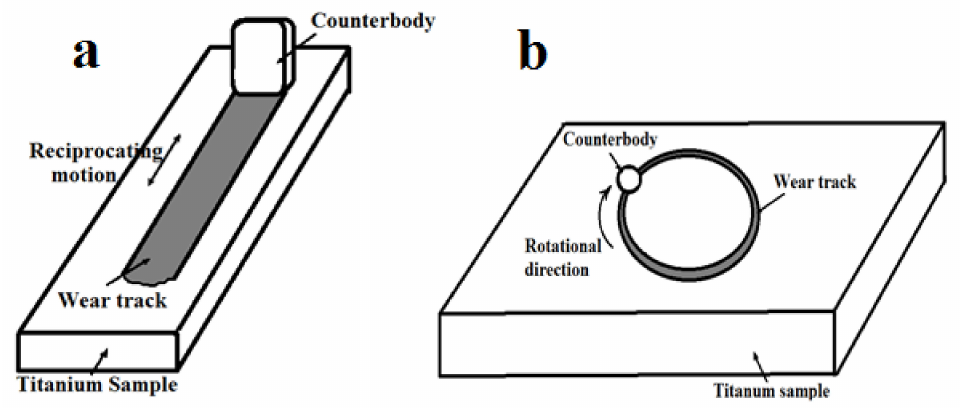
Figure 2. Schematic configuration of samples tests on: ( a ) “pin-on-plate” tester, ( b ) “ball-on-disk”